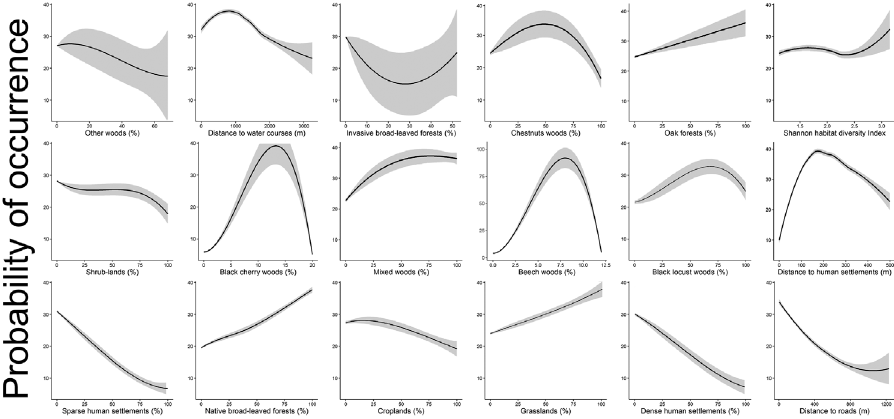
Figure 3. Response curves and 95% confidence intervals (in grey) of the probability of occurrence of the stag beetle derived by the Ensemble of Small Models in relation to predictor variables